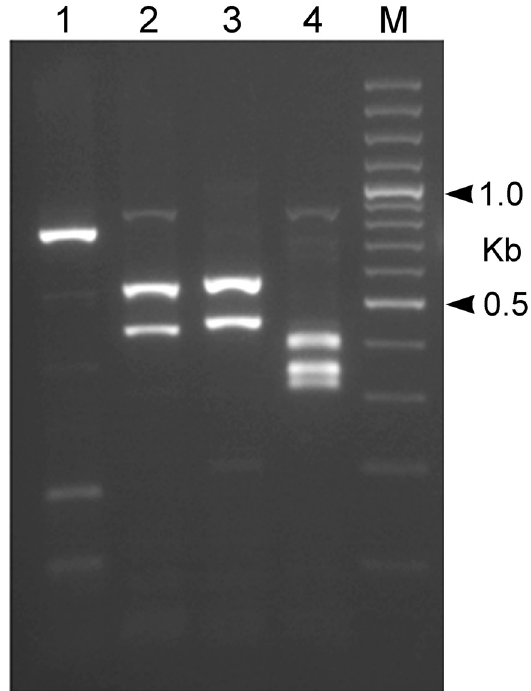
Figure 5. RFLP profiles of the ITS of Heterodera fici digested with four restriction enzymes. M 100 bp DNA ladder (Promega); 1 Alu I 2 Hae III 3 Rsa I 4 Pst